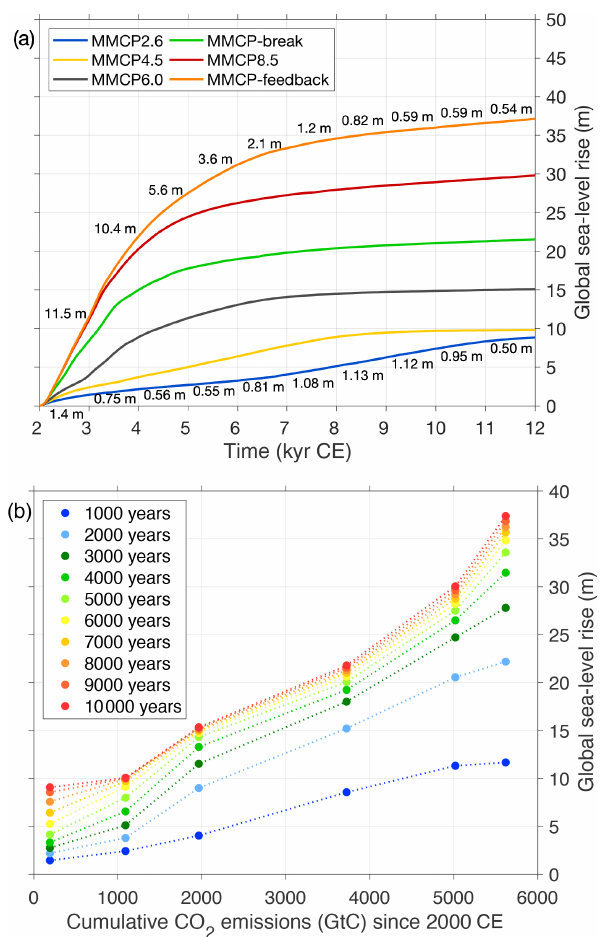
Figure 12. (a) GMSL rise as the sum of the contributions from the AIS, the GrIS, glaciers and ice caps, and the steric component. The rate of sea-level rise during each millennium is indicated for the lowest and highest scenarios. (b) GMSL rise for a given cumulative CO 2 emission at the end of each millennium until 12000CE.